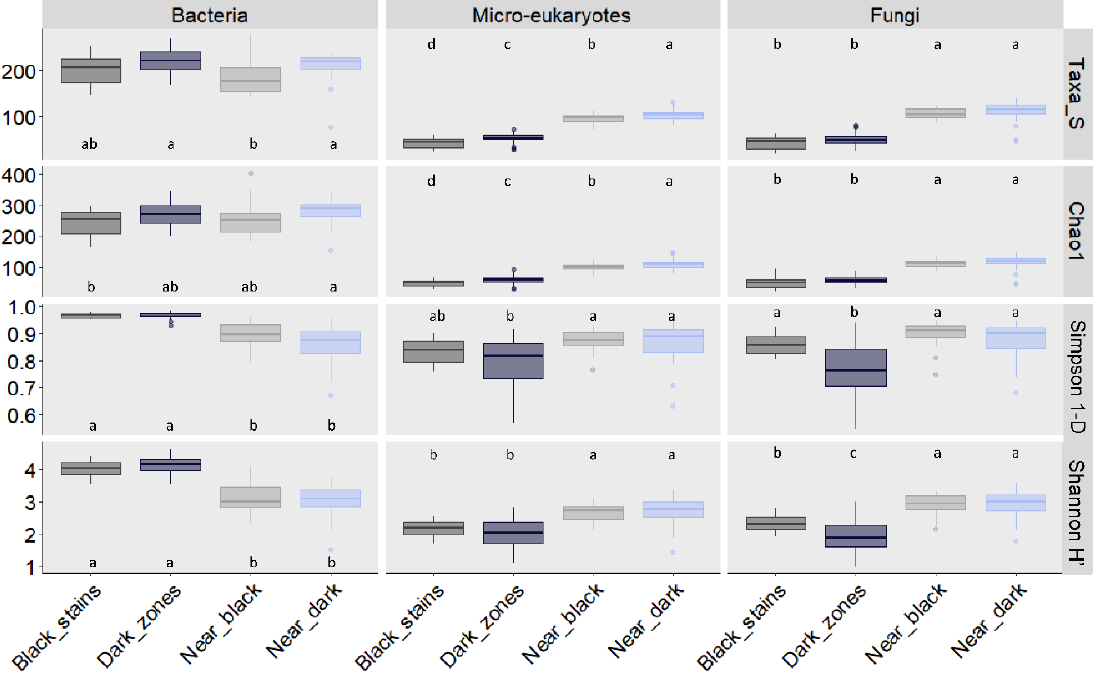
Figure 5. Number of taxa, Chao1 index of OTU richness, Simpson’s index of diversity and Shannon index of OTU diversity for bacteria, micro-eukaryotes and fungi in dark zones (Dark), black stains (Black) and nearby unstained parts (Near Dark and Near Black, respectively) sampled in Lascaux’s Apse walls. Data were combined for the left and right walls sampled in June–July 2015, January 2016, May–June 2016 and December 2016. The differences between conditions are shown with low- ercase letters (based on ANOVA and Tukey’s tests; p < 0.05). Data used for black stains and their